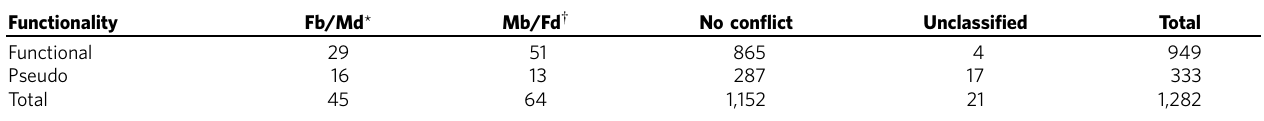
Sexuallyantagonisticgenesin D.miranda wereidentifiedbasedonahomologysearchagainst D.melanogaster genes,amongwhichInnocentiandMorrow 31 listedputativesexuallyantagonisticgenes.The ratios of Fb/Md genes to Mb/Fd genes for functional genes and pseudogenes were different with marginal significance ( w 2 test: P ¼ 0.076). *Genes with female-benefit/male-detriment effects. w Genes with male-benefit/female-detriment